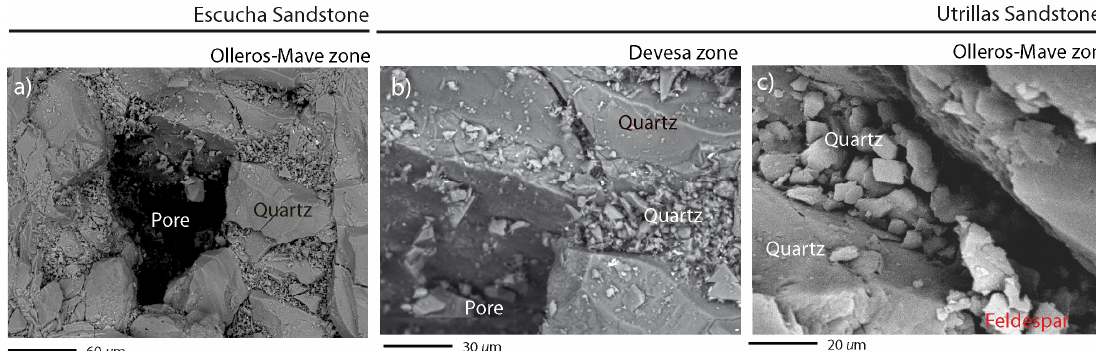
Figure 5. Characteristic textural features of the detrital rocks observed by SEM. ( a ) Homogeneous grain size and dominantly quartz composition of the Escucha sandstones (Mave site). ( b , c ) Mono- and polycrystalline quarts grains of highly heterogeneous size in the Utrillas sandstones (Devesa site and Olleros site).